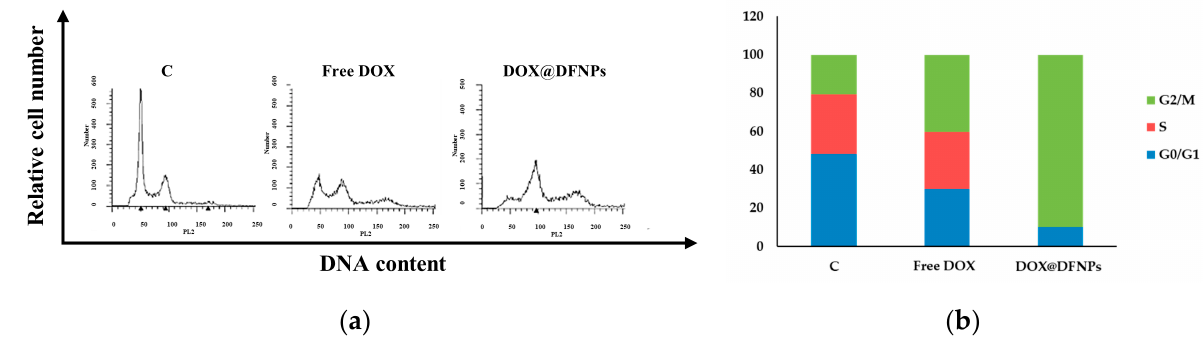
Figure 12. Effects of free DOX and DOX@DFNPs on cell cycle distribution in breast cancer cells. ( a ) Flow cytometry analysis of the cycle profile of breast cancer cells. MDA-MB-231 treated with 0.32 µ g mL − 1 free DOX or DOX@DFNPs for 48 h, stained with propidium iodide (PI) and analyzed on a FACS flow cytometer. ( b ) Quantitative analysis of percentage gated cell at G 0 /G 1 , S, and G 2 /M phases. C = control.